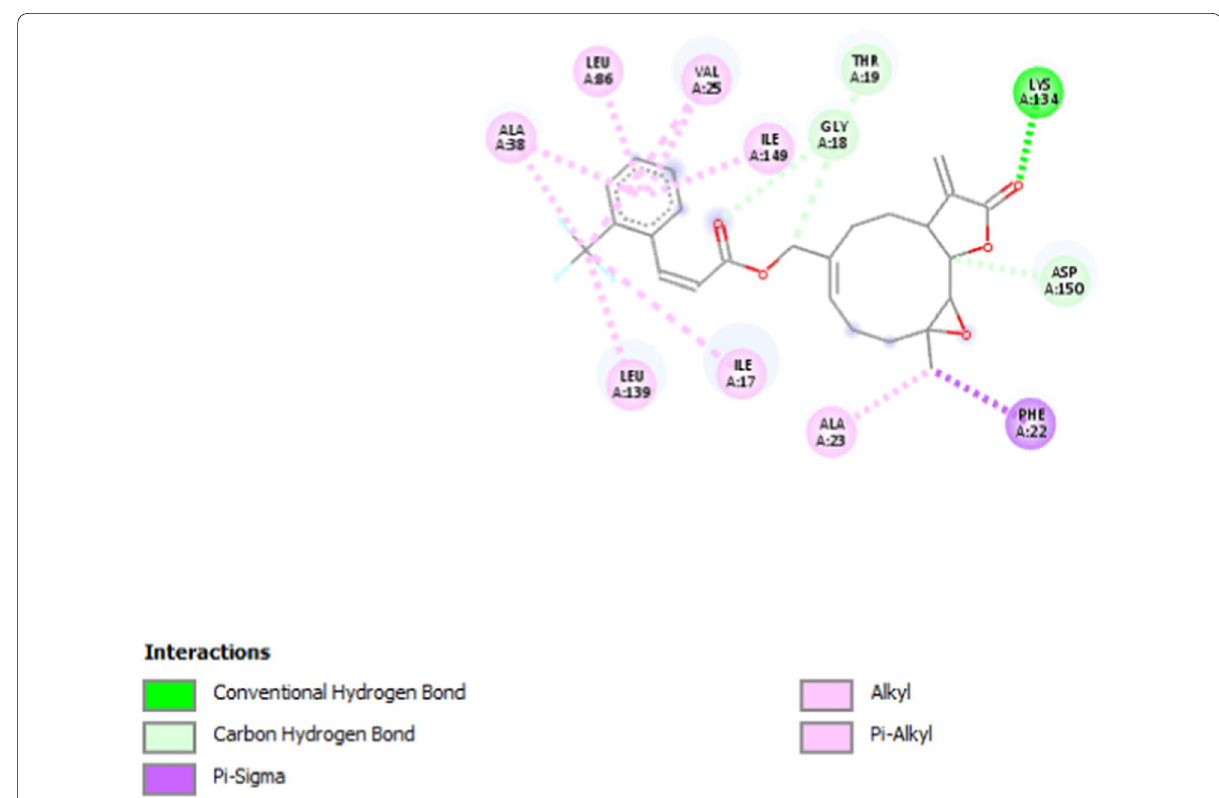
Fig. 7 2D representation of complex